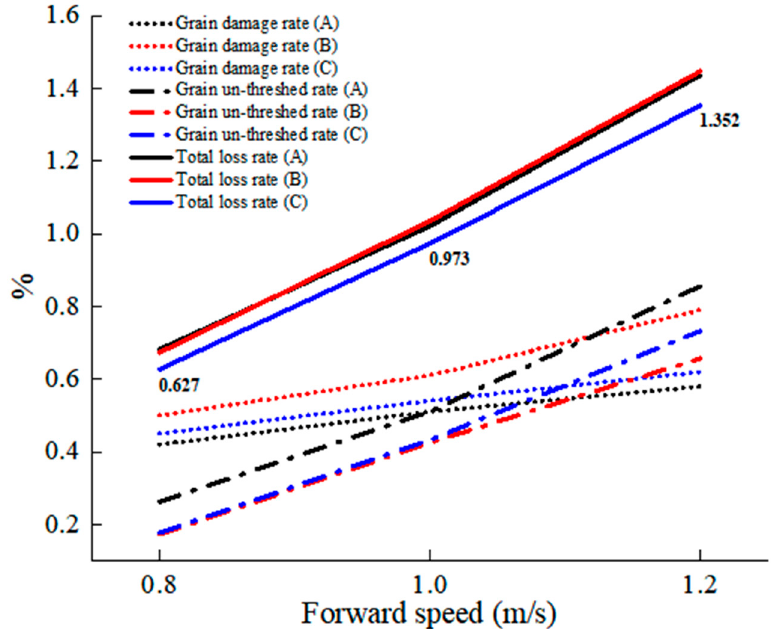
Figure 14. The relationship among the grain unthreshed rate, grain damage rate, total loss rate, and forward speed for different threshing gaps of the concentric threshing device: (A) single threshing gap of 15 mm; (B) single threshing gap of 10 mm; (C) multi-threshing gaps of 10 mm and 15 mm; the numbers denote the total loss rate of C.